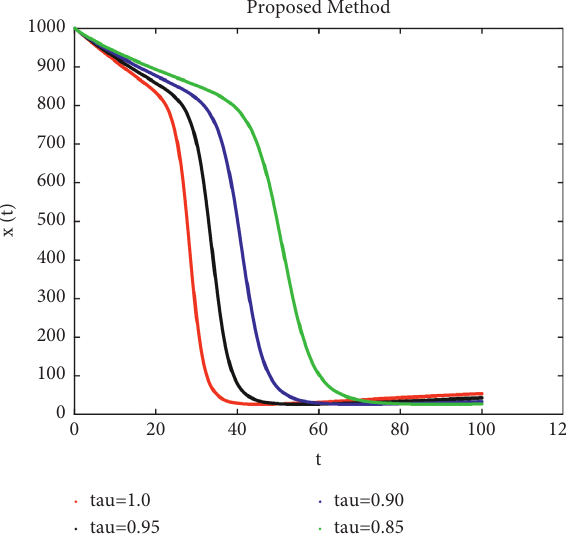
Figure 3: Dynamical behavior of concentration of uninfected (sus- ceptible) cells at α � 1 and various fractal order � 0.85, 0.9, 0.95, 1 under power law kernel.